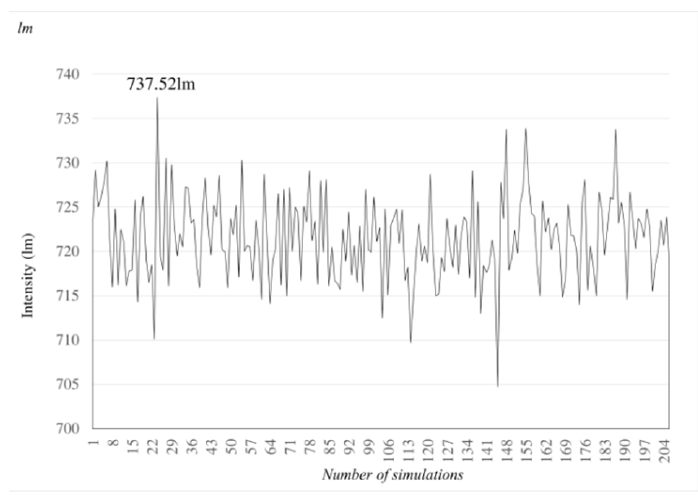
Figure 19. Recorded data of intensity sensor versus running cycles.